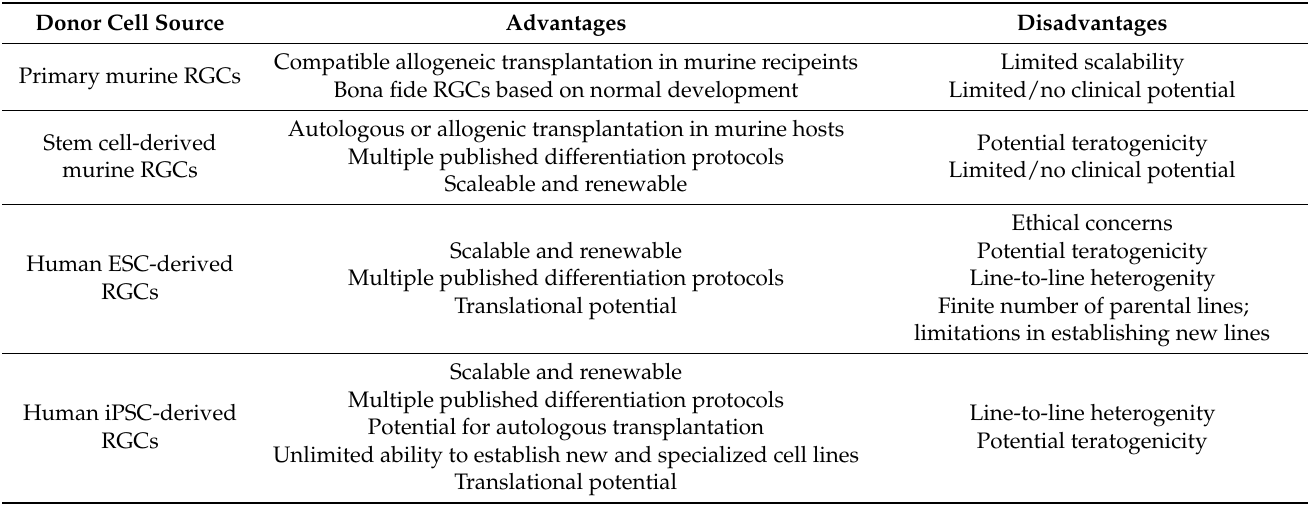
Table 1. Summary of RGC sources for experimental, and potentially clinical,